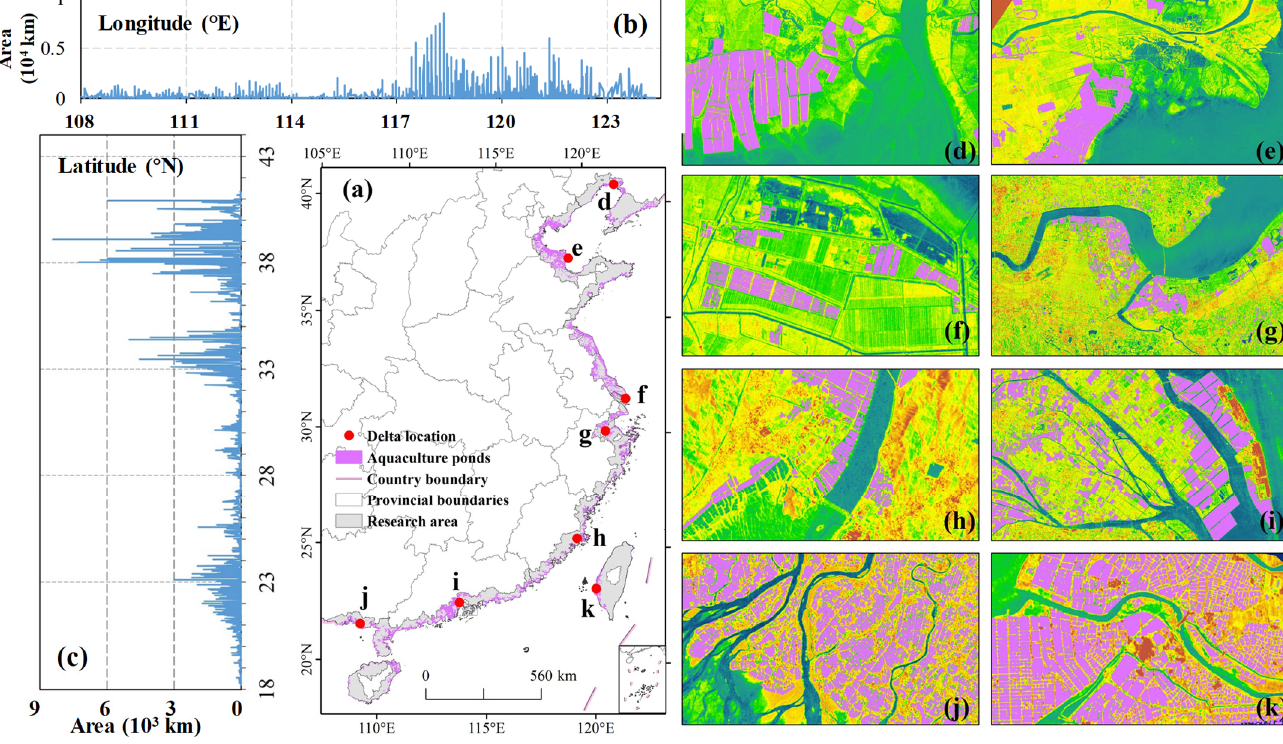
Figure 7. Spatial distribution characteristics of aquaculture ponds along the coast of China. ( a ) The spatial distribution of aquaculture ponds; ( b ) the aquaculture pond area at 0.1 ◦ longitude; ( c ) the aquaculture pond area at 0.1 ◦ latitude; ( d – k ) superimposed images of the eight estuary delta Sentinel- 1 images and aquaculture ponds, in which ( d ) is the Liaohe delta (121 ◦ 47 (cid:48) 41 (cid:48)(cid:48) E, 40 ◦ 54 (cid:48) 23 (cid:48)(cid:48) N); ( e ) is the Yellow River delta (119 ◦ 4 (cid:48) 39 (cid:48)(cid:48) E, 37 ◦ 45 (cid:48) 40 (cid:48)(cid:48) N); ( f ) is the Yangtze Estuary delta (121 ◦ 35 (cid:48) 53 (cid:48)(cid:48) E, 31 ◦ 33 (cid:48) 36 (cid:48)(cid:48) N); ( g ) is the Qiantang River Delta (120 ◦ 46 (cid:48) 50 (cid:48)(cid:48) E, 30 ◦ 11 (cid:48) 15 (cid:48)(cid:48) N); ( h ) is the mouth of Xinghua Bay in Fujian (119 ◦ 15 (cid:48) 23 (cid:48)(cid:48) E, 25 ◦ 28 (cid:48) 57 (cid:48)(cid:48) N); ( i ) is the Pearl River Delta (113 ◦ 39 (cid:48) 48 (cid:48)(cid:48) E, 22 ◦ 41 (cid:48) 28 (cid:48)(cid:48) N); ( j ) is the Nanliujiang Delta in Guangxi (109 ◦ 3 (cid:48) 5”E, 21 ◦ 36 (cid:48) 58 (cid:48)(cid:48) N); and ( k ) is the Jishuixi Delta in Taiwan (120 ◦ 7 (cid:48) 40.15 (cid:48)(cid:48) E, 23 ◦ 17 (cid:48) 35 (cid:48)(cid:48)